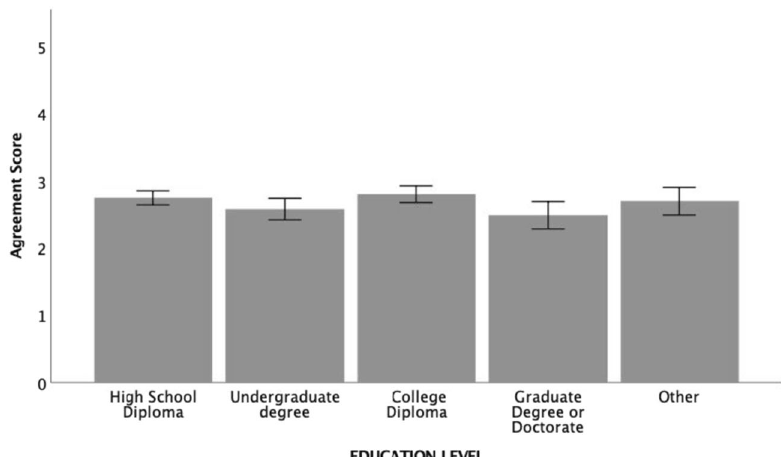
Fig. 6 Consumer level of understanding of branding and marketing of eco-friendly (sustainable) packaging by education level. Error bars indicate